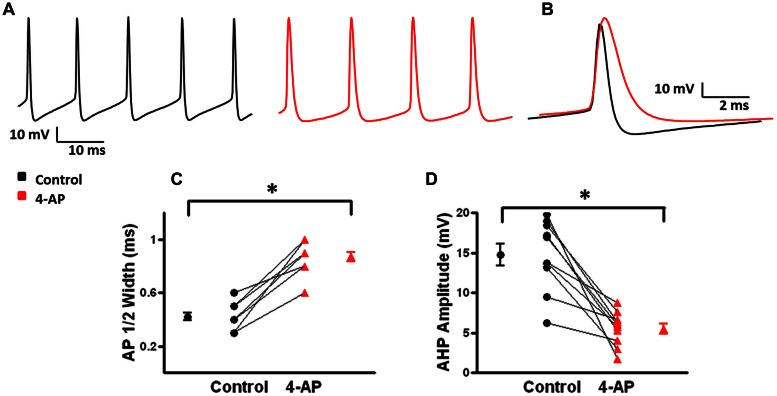
Effects of 4-AP on action potential (AP) properties of FS-BCs. (A) Representative firing from a L2/3 FS-BC during a 400 pA depolarizing current pulse before (black) and after (red) bath application of 100 uM 4-AP. 4-AP induced spike widening and decreases in fAHP amplitude. (B) Superimposition of APs from A before and after 4-AP demonstrates significantly increased AP duration and decreased AHP amplitude. (C) Summary plot showing that bath application of 4-AP significantly increases AP half width of FS-BCs (n = 10). (D) Summary plot illustrating that 4-AP significantly decreases AHP amplitudes in FS-BCs (n = 10). ∗p < 0.05.